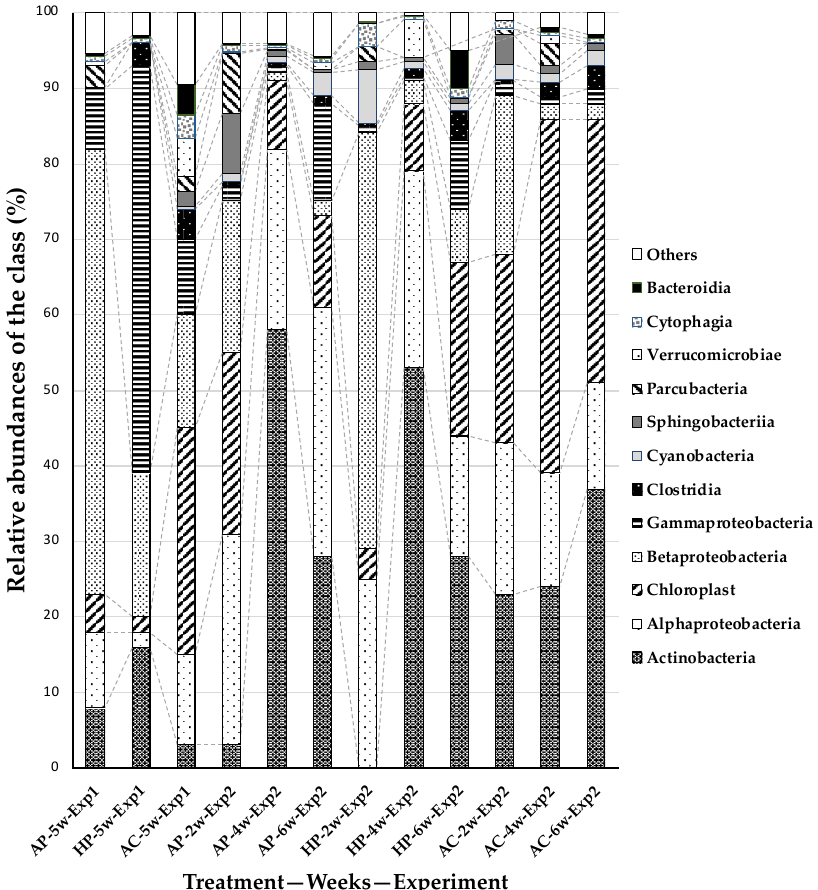
Figure 4. The relative abundance of classes in each sample in Exp. 1 and 2. AP: aquaponics, HP: hydroponics, AC: aquaculture. Classes representing less than 1% of the total reads were categorized under Others including Chlamydiia, Flavobacteriia, Spartobacteria, Negativicutes, Subdivision 3, Planctomycetia, Deltaproteobacteria, Bacilli, Candidatus Saccharibacteria, Caldilineae, Opitutae, Fusobacteriia, Epsilonproteobacteria, Gemmatimonadetes, Erysipelotrichia, Nitrospira, and 22 classes. Principal coordinate analysis using 2177 OTUs in the three plots at 5 WAT of Exp. 1 and 2, 4, and 6 WAT of Exp. 2 showed that the bacteria flora tended to depend on the sampling dates rather than the treatments (Figure